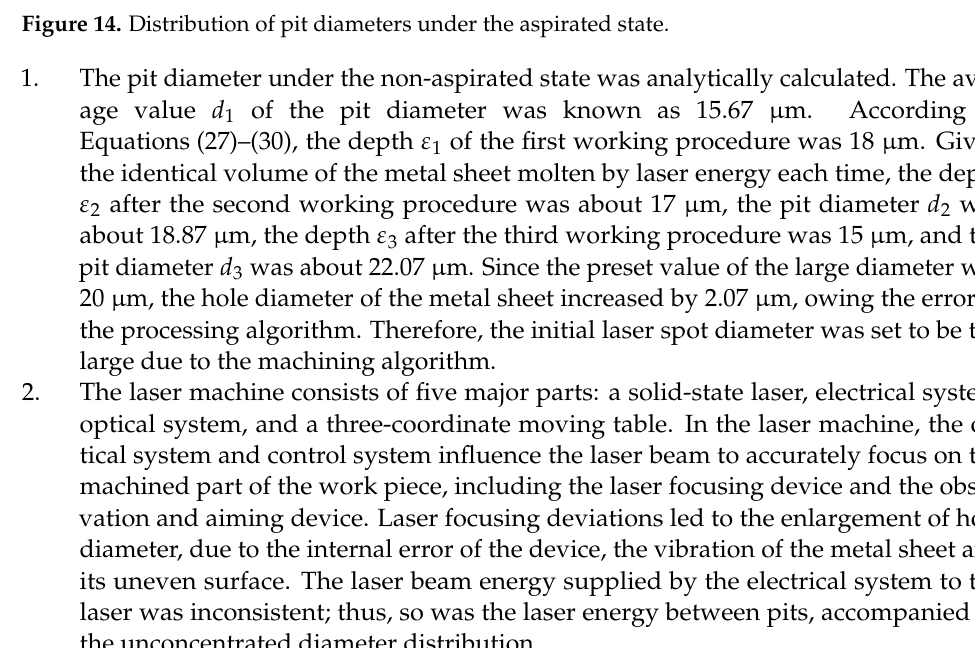
Figure 14. Distribution of pit diameters under the aspirated state.